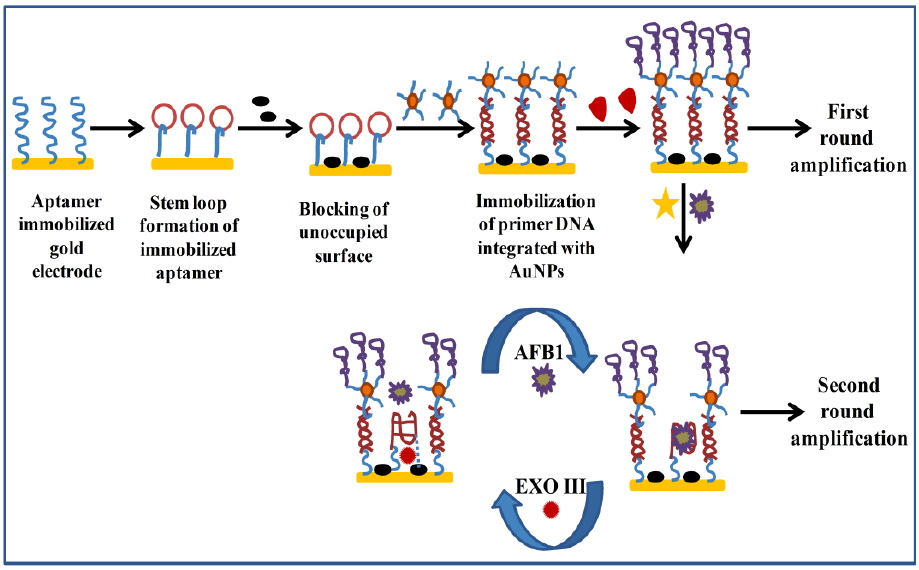
Figure 4. Schematic representation of two signals amplified signal on an electrochemical aptasensor for AFB1 detection (scheme illustration from [82].